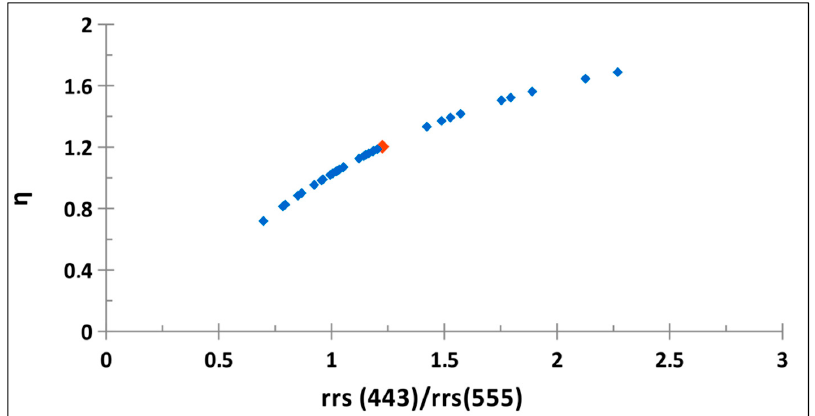
Figure 9. Plot of the power-law relationship between η and the averaged ratio r rs (443)/r rs (555). The red square indicates the selected η value.